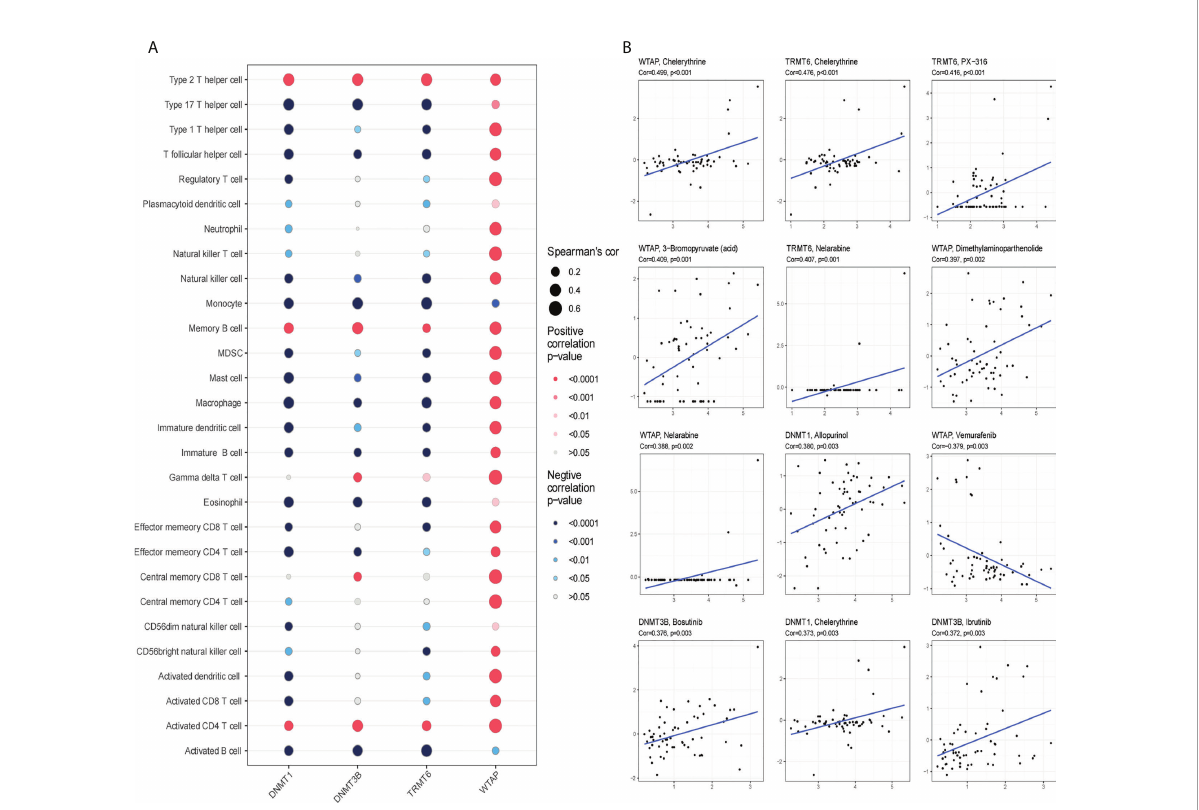
FIGURE 10 Immunoin fi ltration and drug sensitivity analysis. (A) WTAP , TRMT6 , DNMT1 and DNMT3B are correlated with immune in fi ltration in patients with glioma. Red signi fi es positive correlation, blue represents negative correlation; the deeper the color is, the smaller the P-value is and the larger the dot, the larger the absolute value of the correlation coef fi cient. (B) Sensitivity of WTAP , TRMT6 , DNMT1 and DNMT3B to drugs (*P <